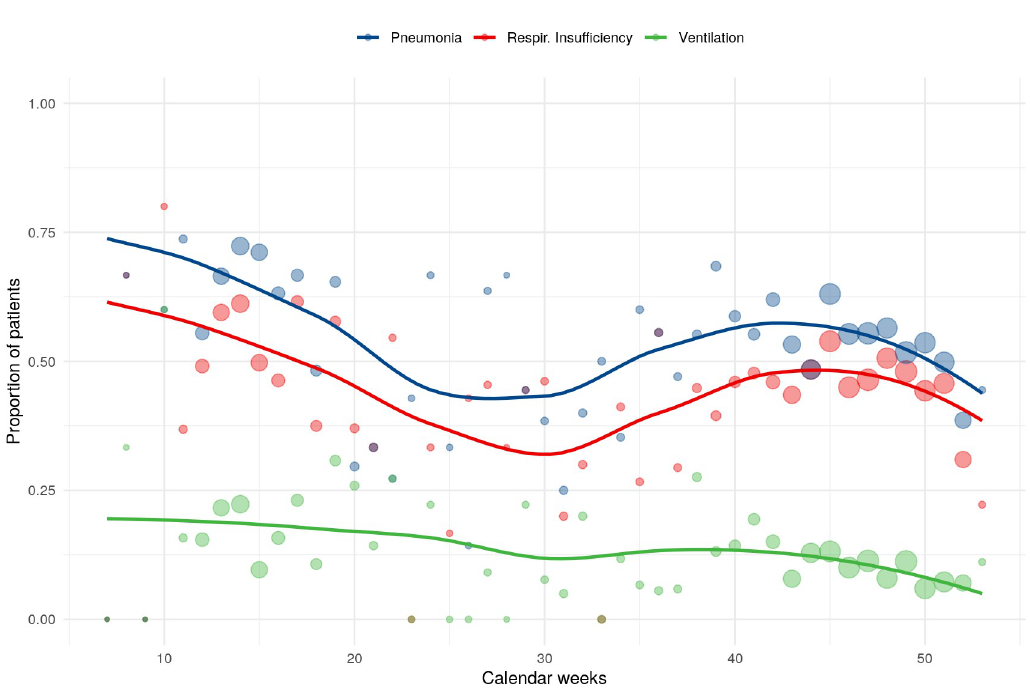
Fig 5. Temporal trend of pneumonia, respiratory insufficiency and need for ventilation during the year 2020, based on the total study cohort (n = 4704). Dot size: small = up to 20 cases, medium = 21–40 cases, big = 41–60 cases.